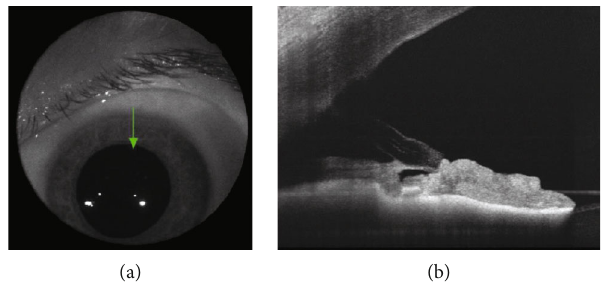
Figure 1: XEN stent placement (a) and anterior segment OCT (b) showing obstruction of XEN stent lumen after pupil